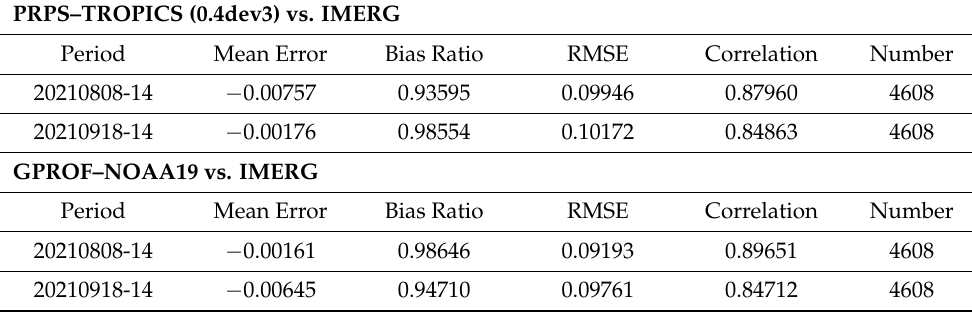
Table 2. Statistical performance of the 2.5 × 2.5 degree. Seven-day precipitation totals from the